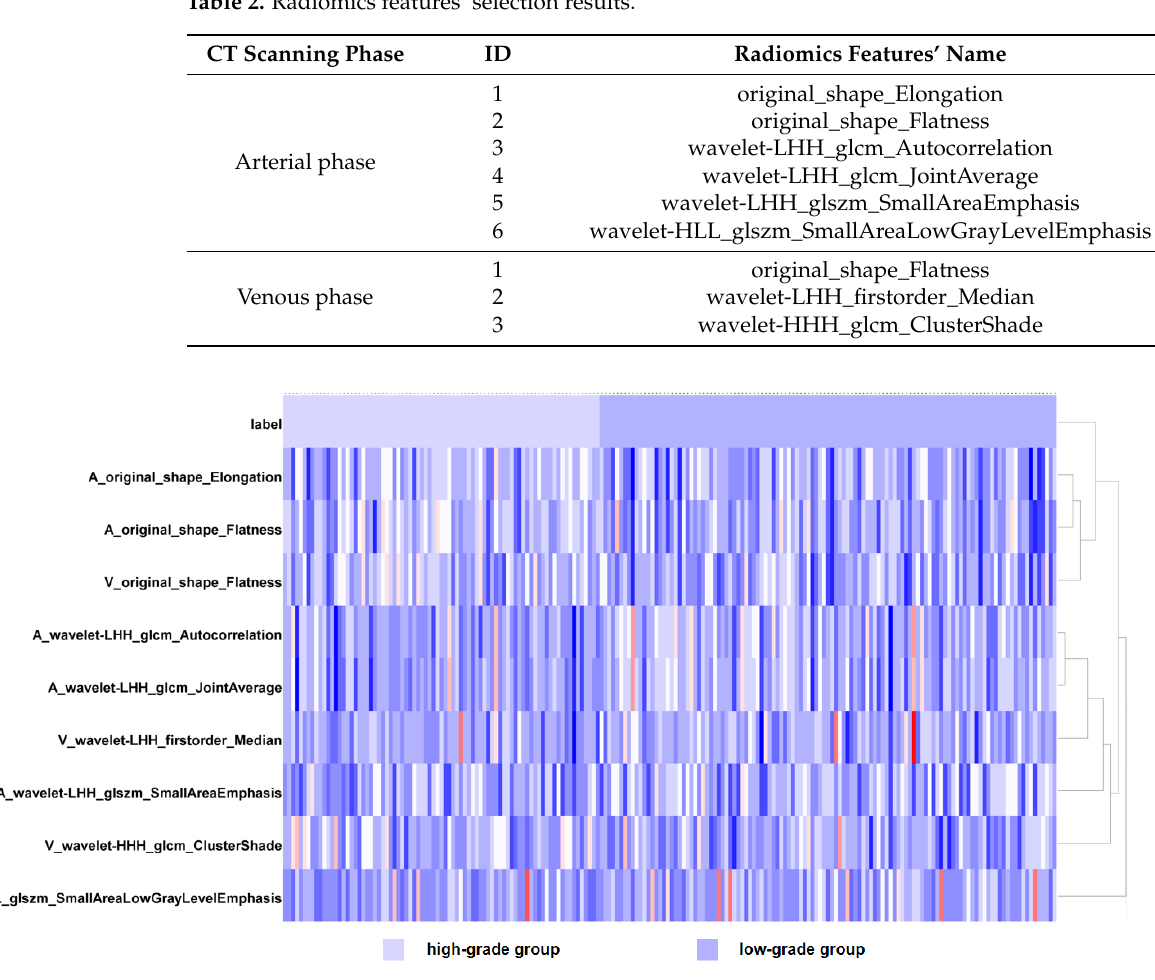
Figure 4. Heatmap of nine radiomics features including. The heatmap is grouped according to the low-grade group and the high-grade group. Each row corresponds to one radiomics feature, and each column corresponds to one patient. The rightmost lines represent hierarchical clustering of radiomics features, shown as a dendrogram.